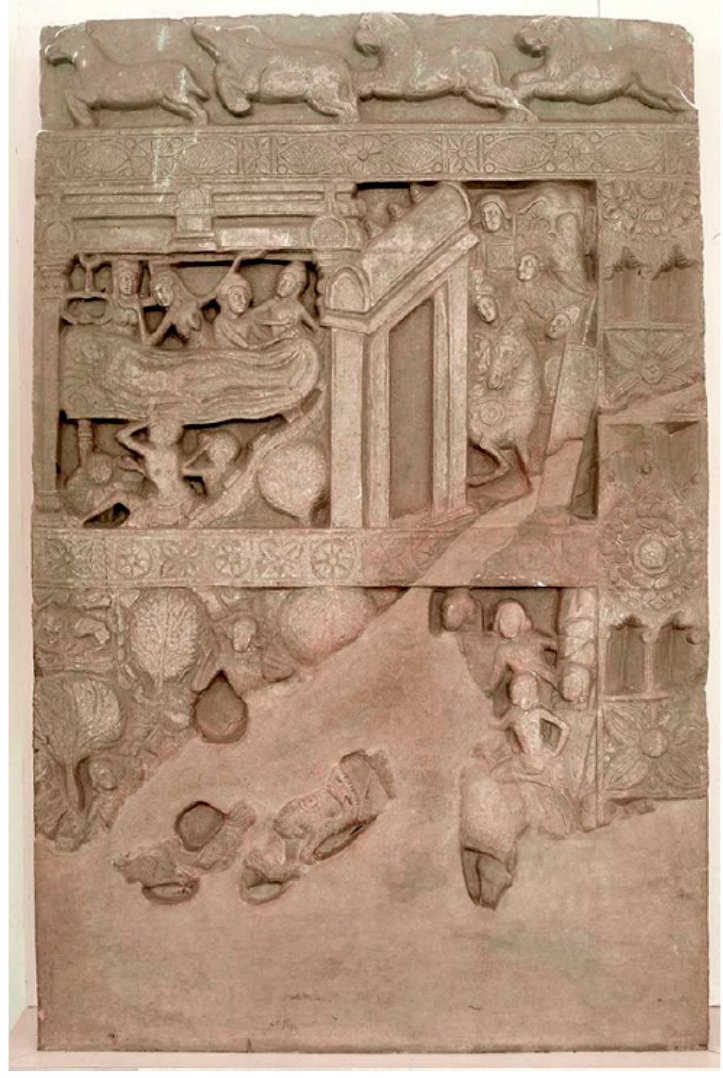
Figure 9. Nagarjunakonda, Archaeological Site Museum, no. 28 © photograph Wojtek Oczkowski with kind permission of ASI. Religions 2020 , 11 , 103